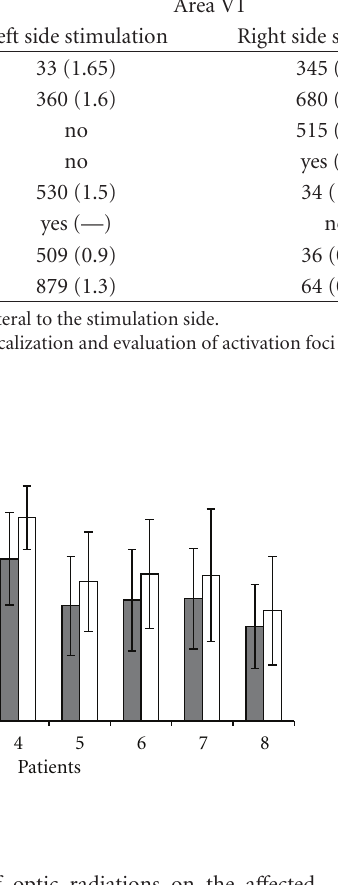
Figure 5: Mean FA values of optic radiations on the a ff ected (grey bars) and una ff ected side of all optic neuritis patients. Partial overlapping of error bars indicate a nonsignificant di ff erence between a ff ected and una ff ected side anisotropy.